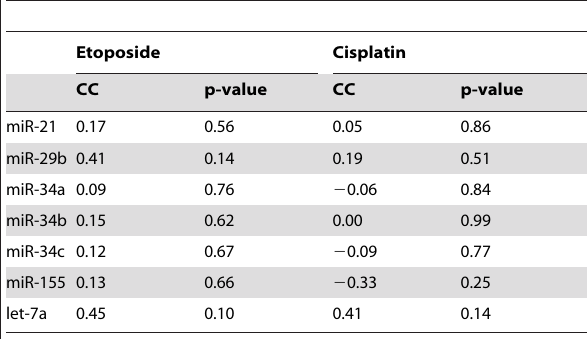
Table 3. microRNA expression and chemosensitivity to etoposide or cisplatin in SCLC cell lines.